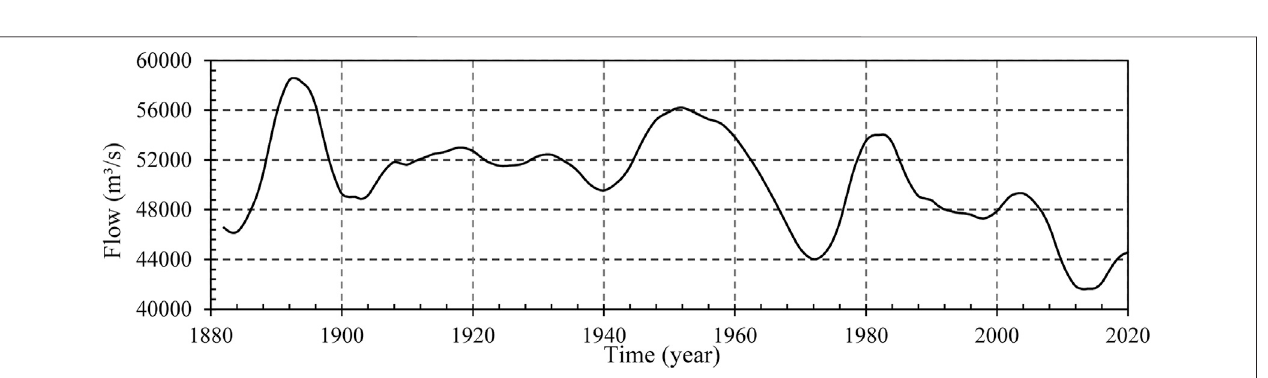
FIGURE 2 | Curve of annual maximum fl ood peak discharge in YC.